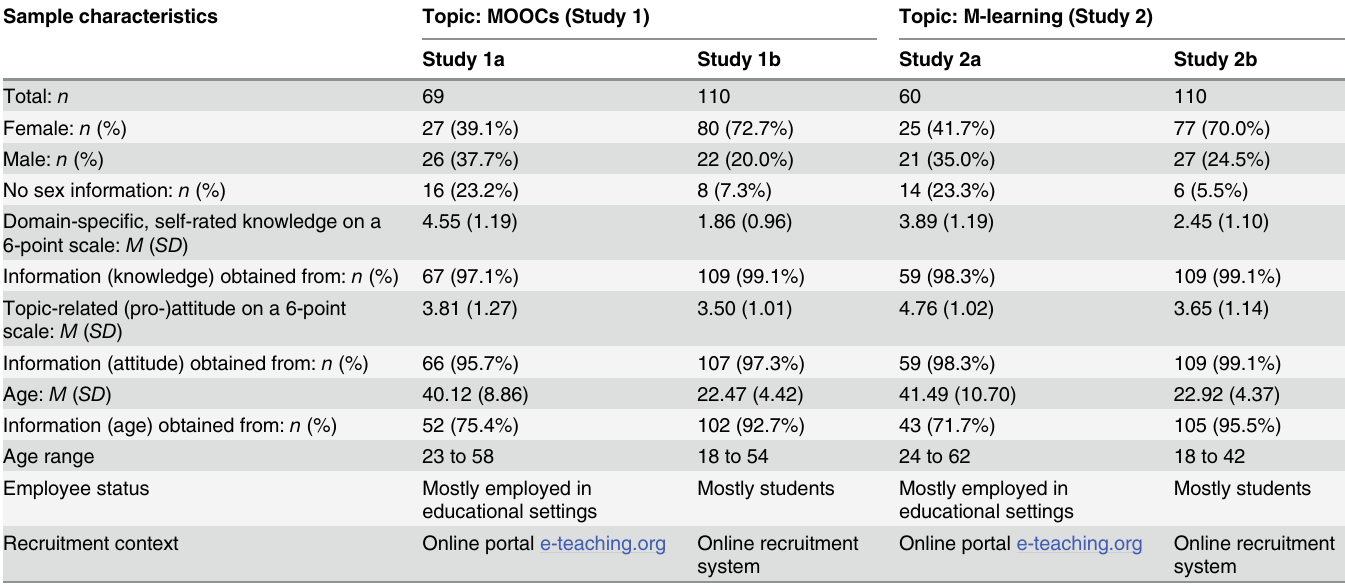
Table 1. Sample description: Participants who rated at least one argument. Sample